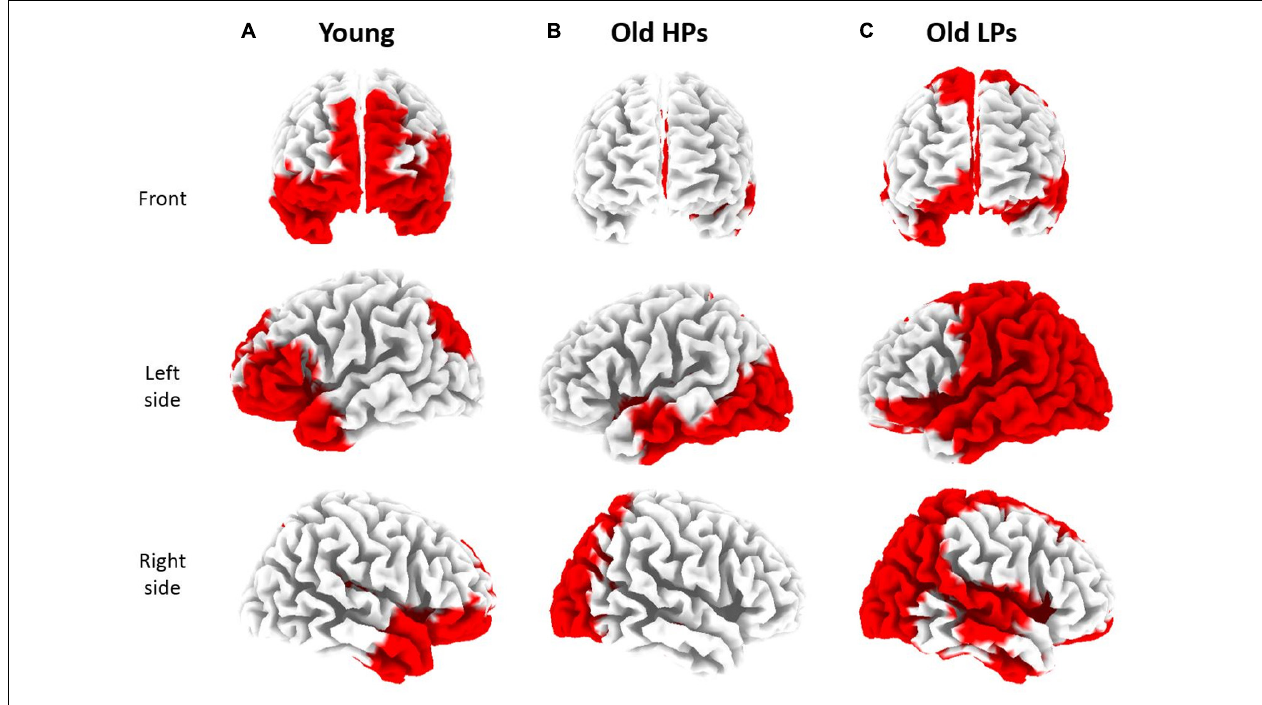
FIGURE 6 | sLORETA based source localization on significant state differences (RS vs. SP) of gamma-band oscillations (GBOs) in three groups. Significantly increased GBOs were observed in frontal and occipital region for younger participants (A) , in parietal and occipital region for elderly high performers [HPs, (B) ], and in frontal, parietal, and occipital regions for elderly low performers [LPs, (C)